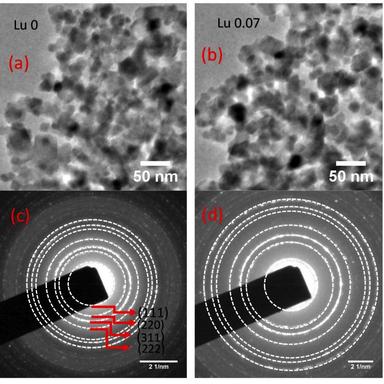
d. TEM and SAED of ZnFe(2-x)LuxO4, where x = 0 (Lu 0) and 0.07(Lu 0.07).